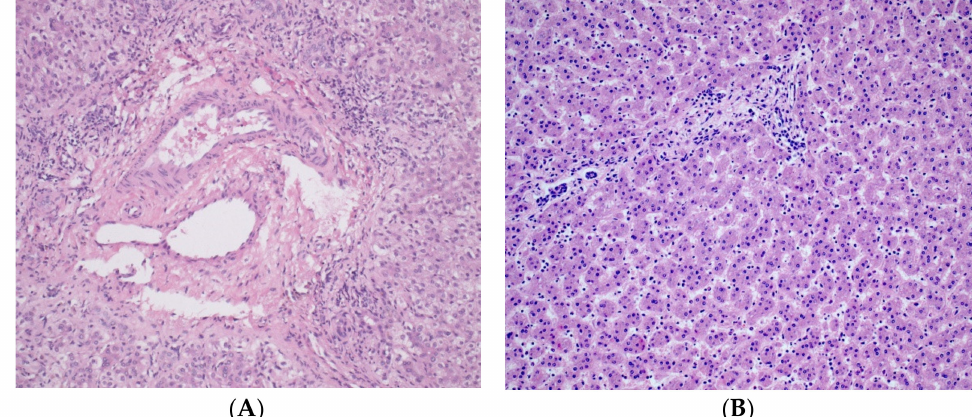
Figure 1. ( A ) Histopathology of liver showing portobiliary area without intrahepatic bile ducts (H&E staining at 200 × magnification, patient no. 4); ( B ) Healthy liver tissue: hepatic parenchyma formed by regular single-row beams of bland hepatocytes and unexpanded portobiliary areas (H&E staining at 200 × magnification).